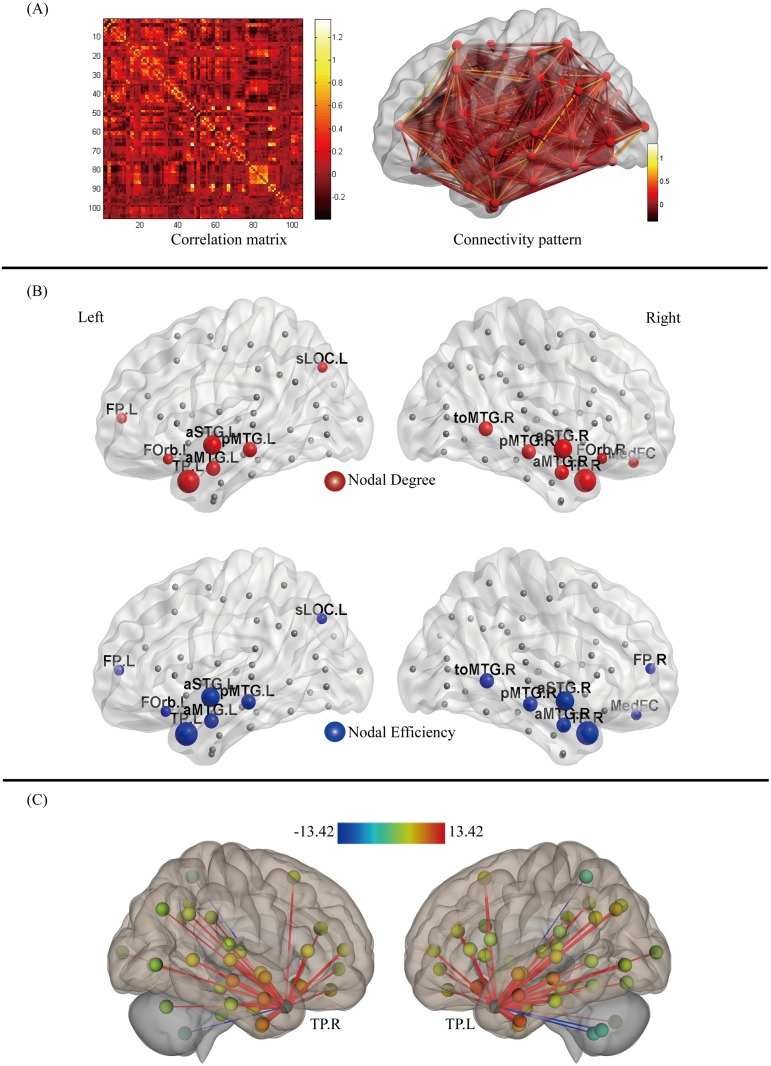
(A) The correlation matrix and the functional connectivity pattern in the brain for processing AV stimuli attended. The color bar indicates the strength of connectivity. (B) The distribution of hubs with high degree and nodal efficiency. The node that degree or efficiency value is larger than the sum of the average value and the standard deviation across all nodes of the network is defined as a hub node. The red spheres are the hubs with high nodal degree, and the blue spheres are the hubs with high nodal efficiency. The size of the spheres indicates the relative size of the nodal degree or efficiency. (C) The strength of functional connectivity between bilateral temporal poles (TP.L and TP.R) with other regions in temporal lobes. The color bar indicates the strength of connectivity.